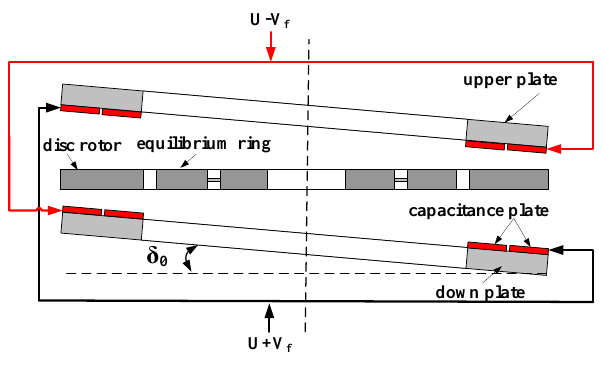
Figure 6. Schematic diagram of the installation error of the capacitance